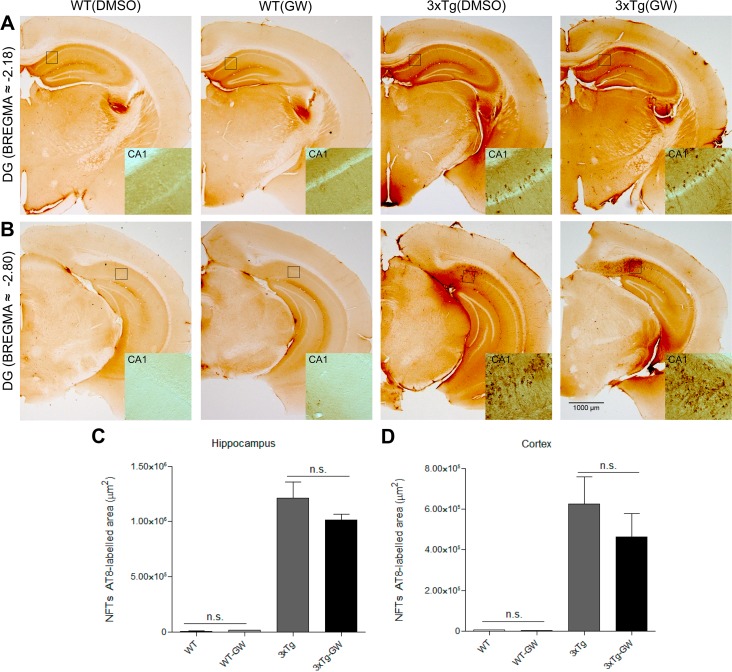
Tau pathology is not significantly reduced by LXR activation.
(A-B) Presence of aggregated phospho-tau in brains of treated and untreated mice groups was evaluated by immunohistochemistry with anti-phospho-tau antibody (AT-8). (C-D) No significant changes were found in the quantification of aggregated phospho-tau occupied area within the hippocampus or cortex in treated mice. Data were expressed as mean ± S.E.M. Statistical analysis was done by one way ANOVA followed by Tukey's multiple comparison test. n = 4 Females per 3xTg-AD group.